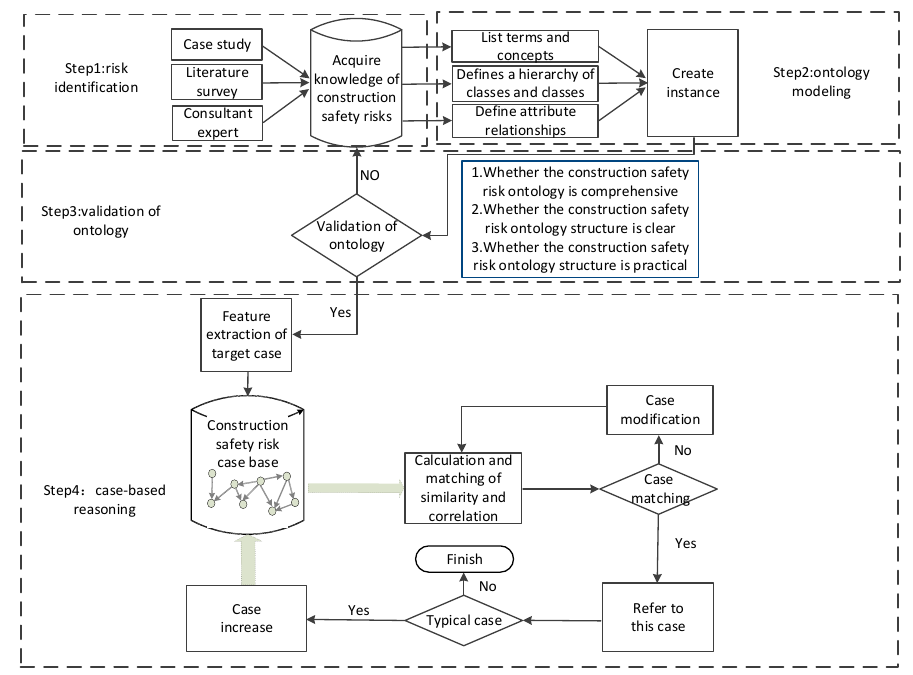
Figure 1. Construction safety risk management decision-making framework and implementation steps based on ontology and